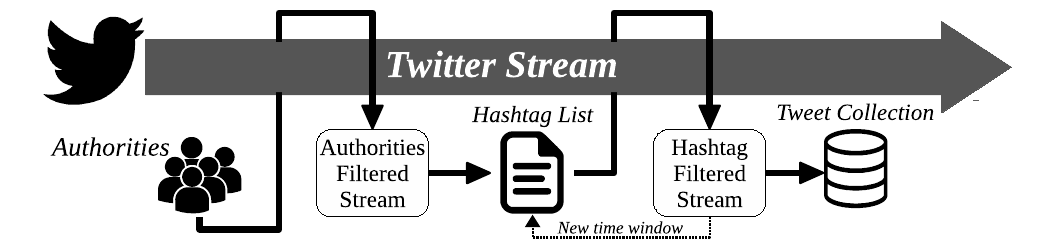
Figure 1. General overview and flow of the proposed